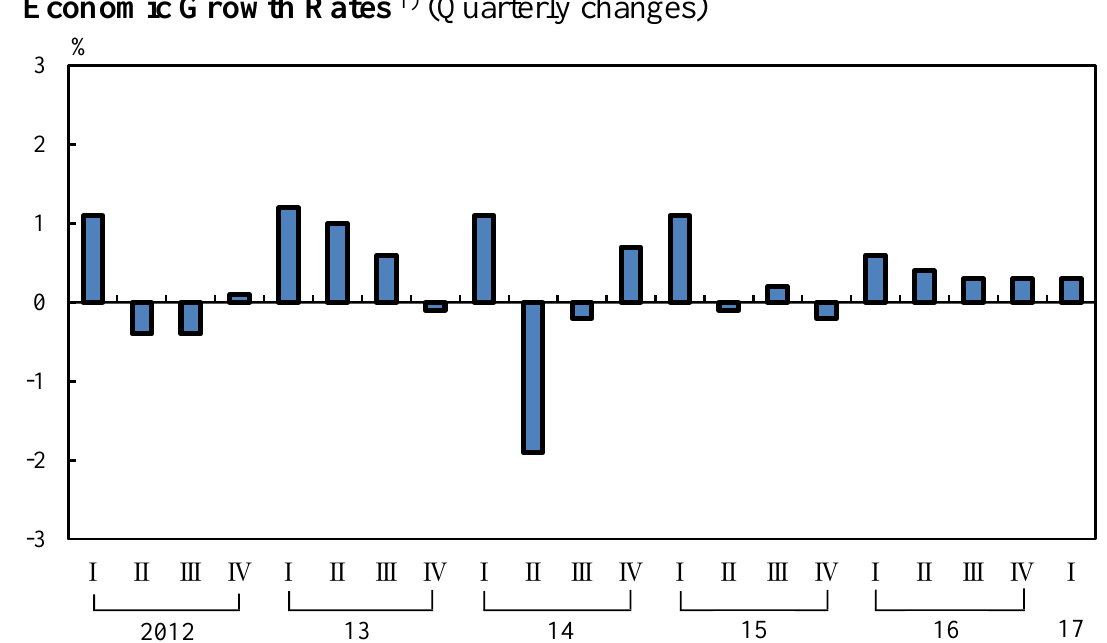
Economic Growth Rates 1) (Quarterly